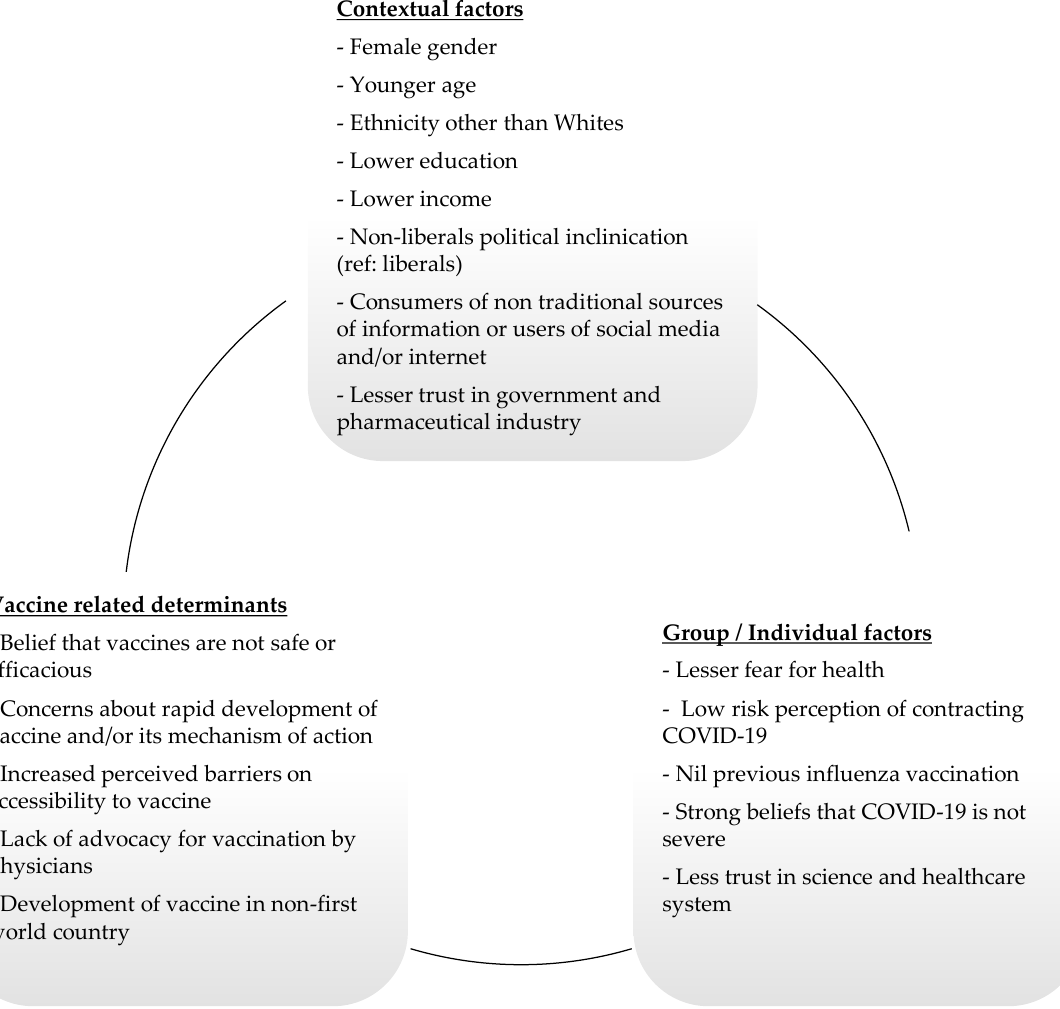
Figure 3. Framework diagram summarizing key determinants of vaccine hesitancy in high-income countries or regions. With respect to ethnicity, Blacks have been shown to have increased mistrust in COVID- 19 vaccination with possible reasons due to racism, discrimination and mistreatment